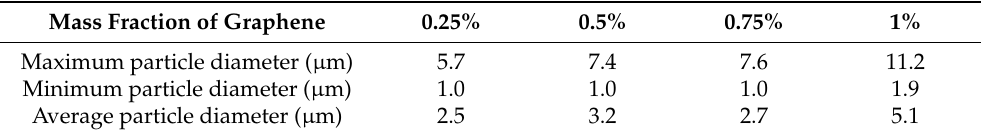
Table 1. Graphene agglomerated particle diameter in micrograph of a hydrogel–graphene coupling agent. Mass Fraction of